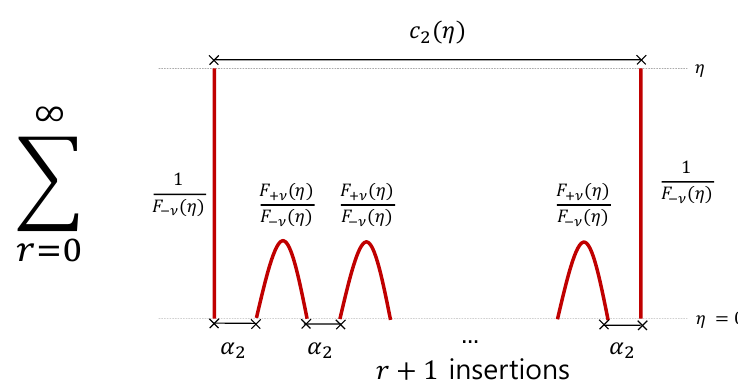
Figure 3 . Adding a quadratic α 2 φ 2 to the boundary wavefunction (at time η = 0 ) affects the two-point coefficient c 2 ( η ) φ 2 at a bulk time η via the resummation shown above. This is analo- gous to a mass insertion, m 2 φ 2 , shifting the propagator from 1 /p 2 to 1 / ( p 2 − m 2 ) in a standard Lorentzian